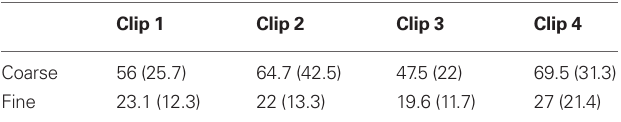
Table 1 | Mean coarse and fine event lengths for each clip in seconds (standard deviations in